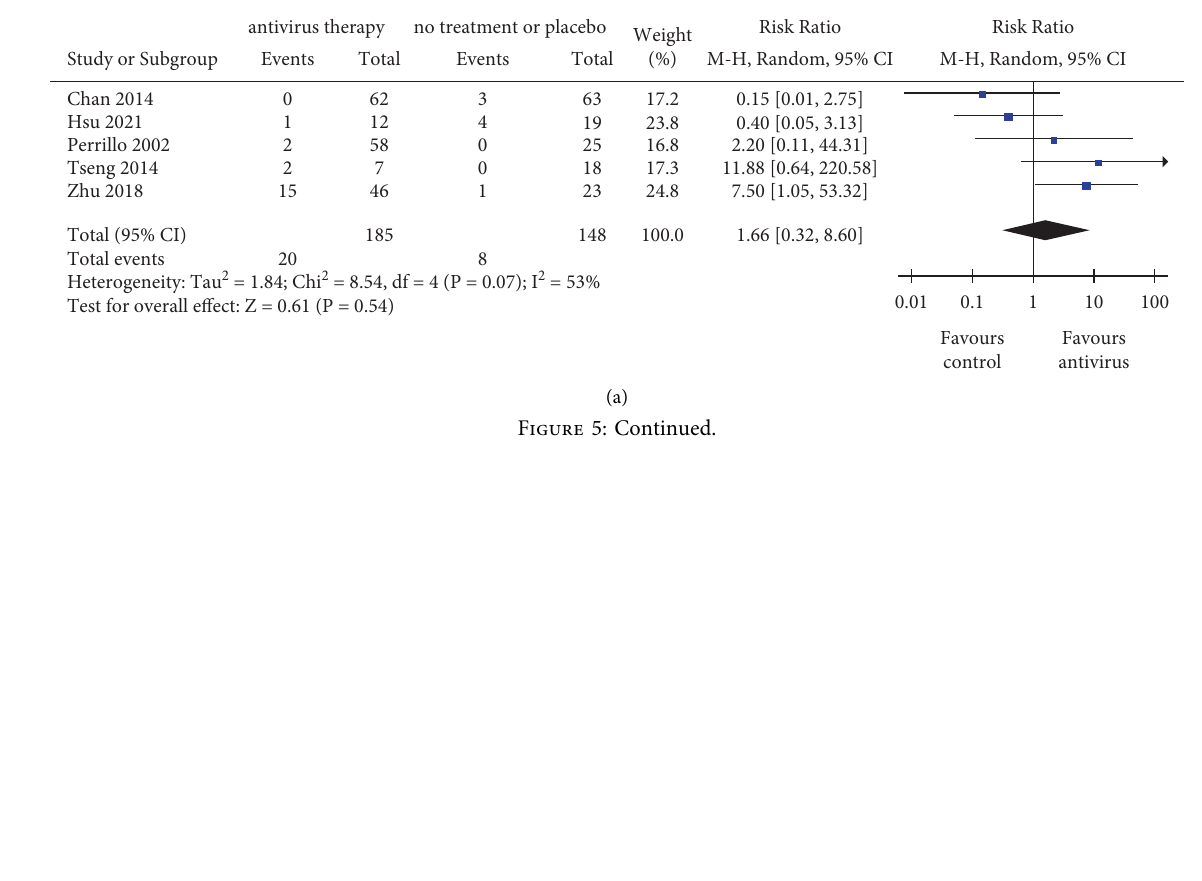
Figure 4: Te outcomes of HBeAg loss. (a) Pooled risk ratio for HBeAg loss between the antiviral therapy group and control group. (b) Subgroup analysis stratifed by therapeutic regimen with or without IFN. (c) Subgroup analysis stratifed by monotherapy and combined therapy (IFN plus NAs). (d) Subgroup analysis stratifed by therapy duration with threshold of 96 weeks. NAs, nucleos(t)ide analogs; IFN, interferon; CI, confdence interval; monotherapy group exclusively included NAs or IFN. Te size of square represents the weight of each study, and the vertical dotted line represents the pooled rate.